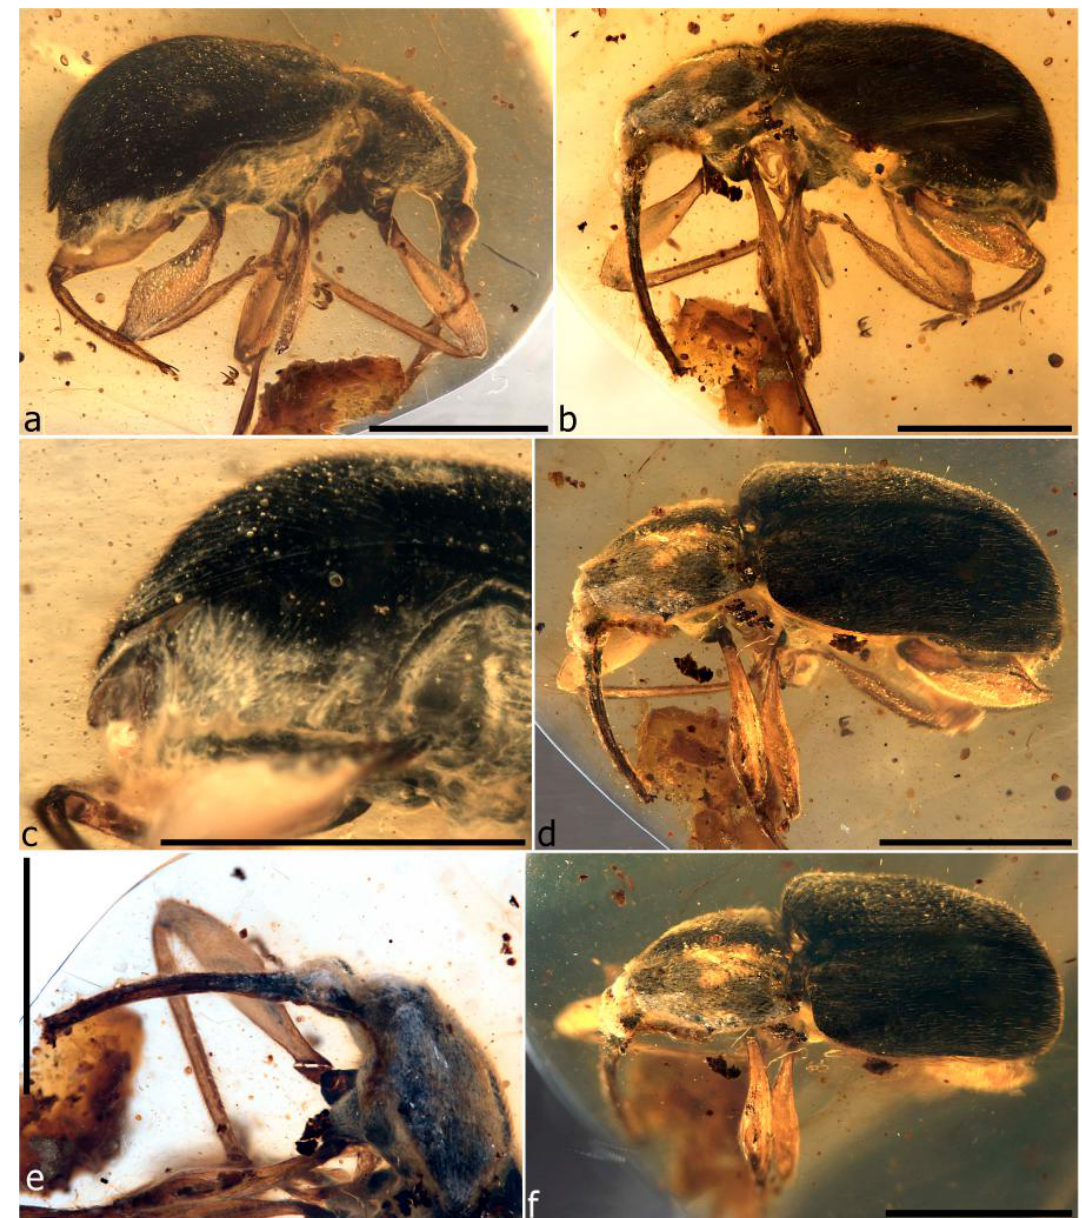
Figure 71. Myanmarus dentifer sp. n., holotype. Habitus, right lateral ( a ); habitus, left lateral ( b ); ventrites, ventral oblique ( c ); habitus, lateral oblique ( d ); head and prothorax, left lateral ( e ); habitus, dorsal oblique ( f ). Scale bars: 1.0 mm (a–f).